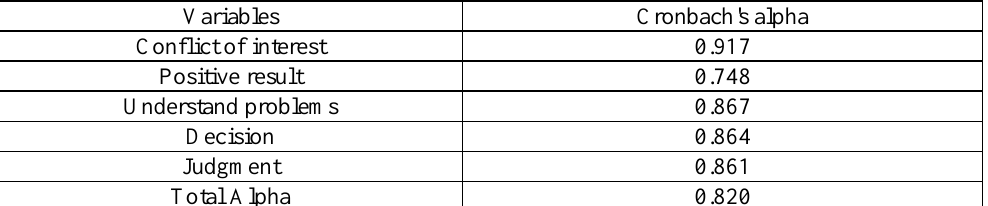
Table 2. Cronbach's alpha coefficient of research variables